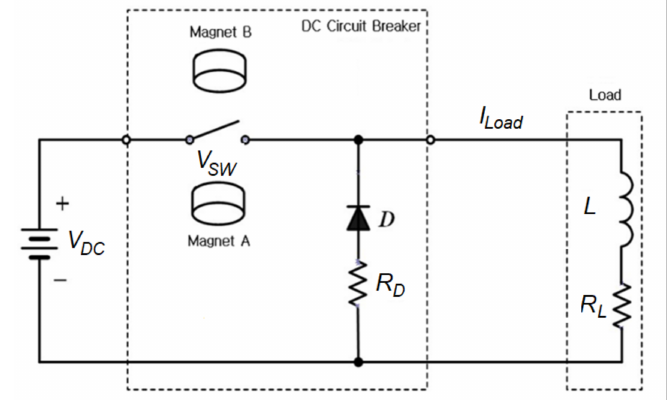
Figure 1. Arc extinguishing concept of the proposed DC switch.